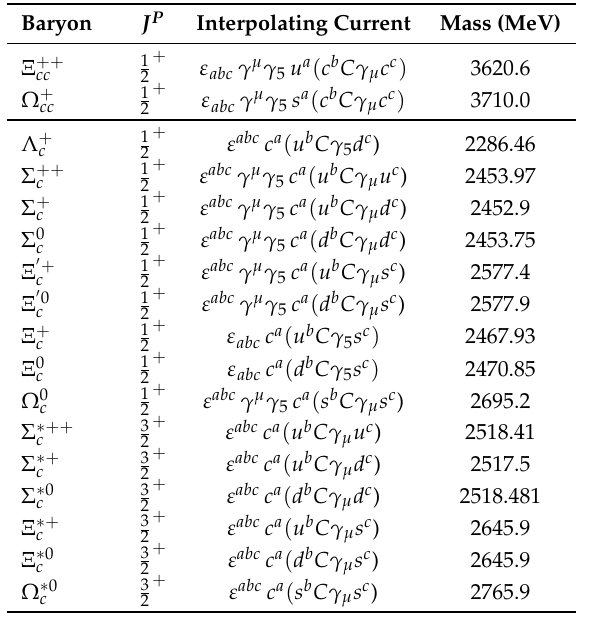
Table 2. Quantum numbers and interpolating currents of single and double charm baryons.